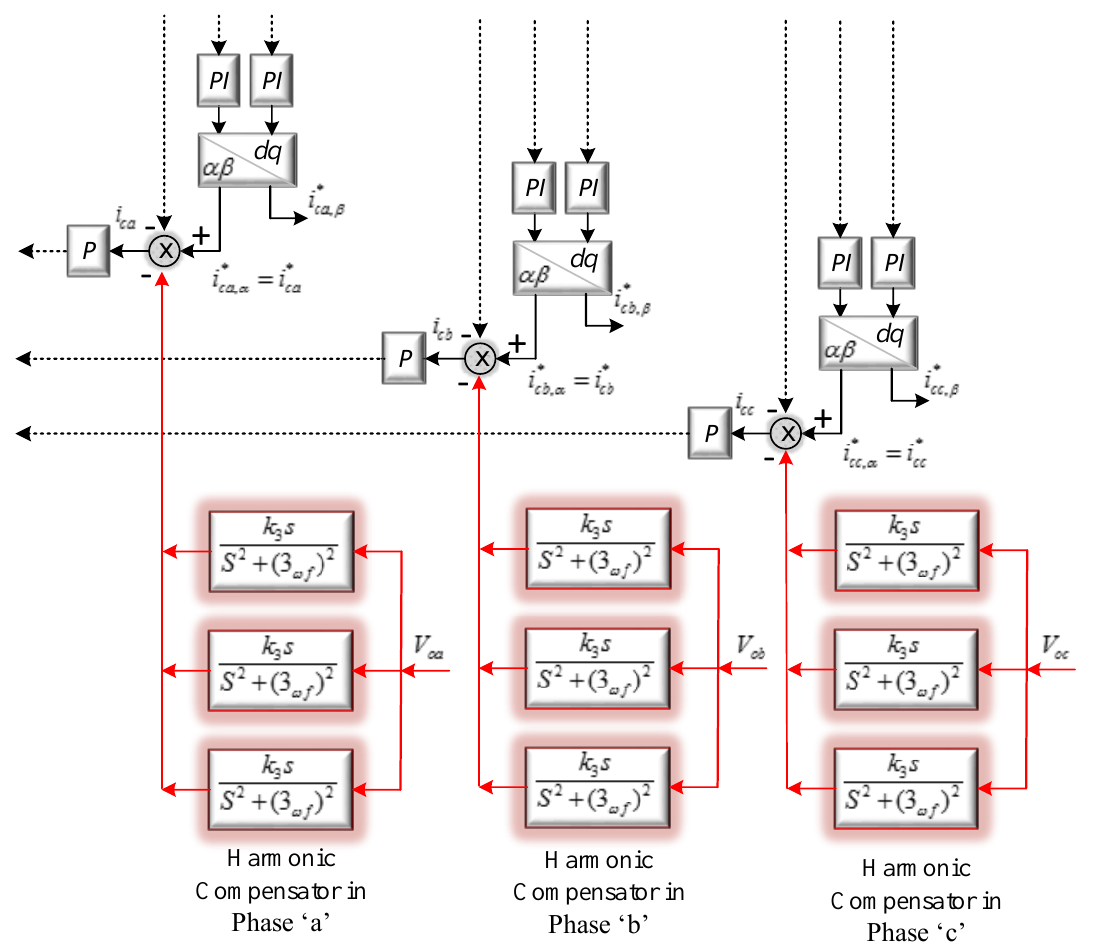
Figure 8. Proposed harmonic compensator.